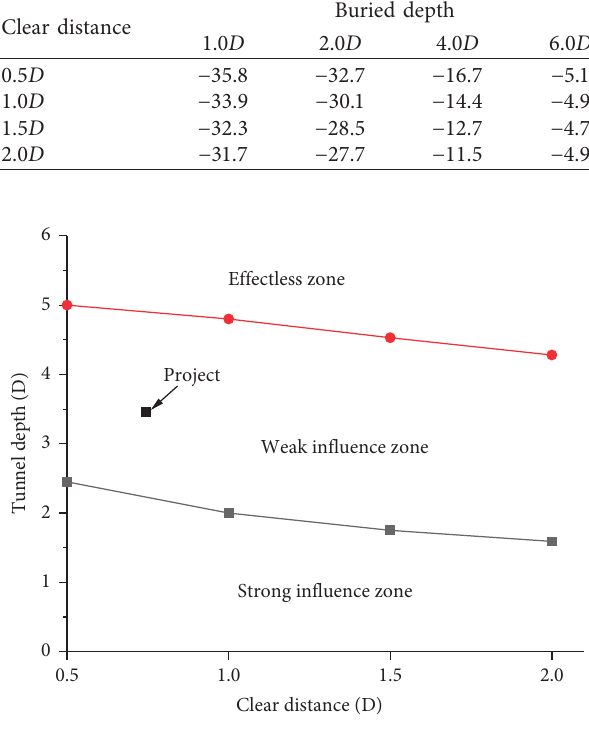
Figure 28: Surface subsidence criteria affect partition.